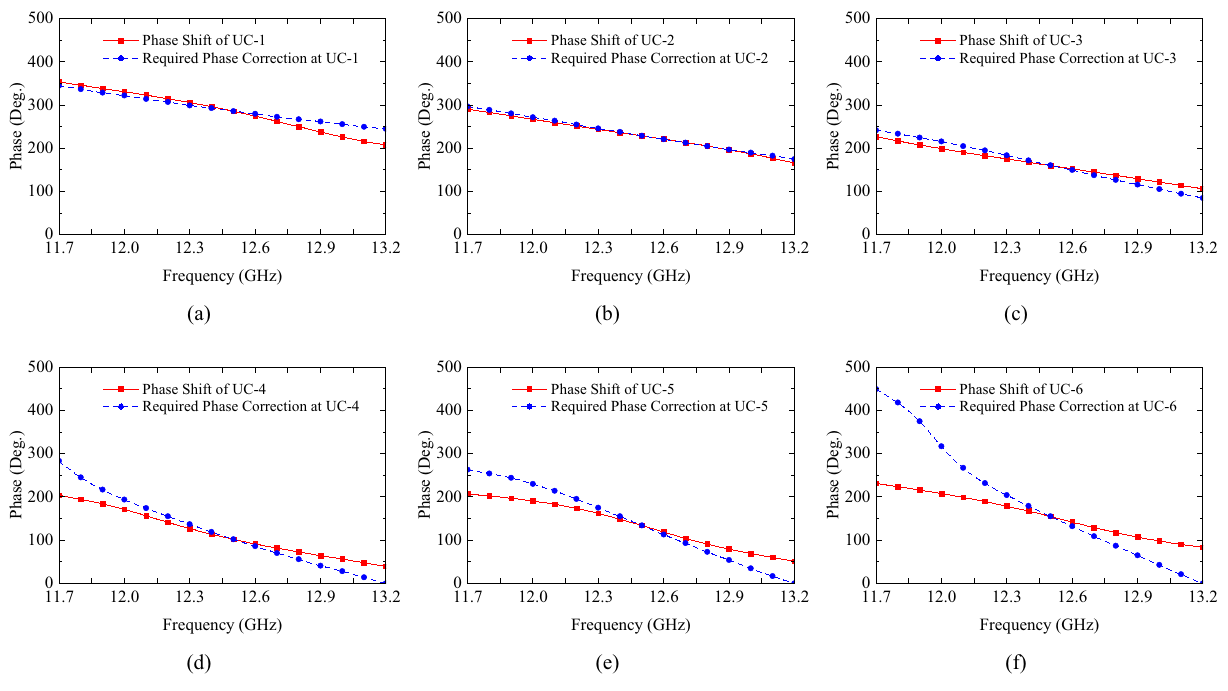
Figure 9. Phase shift of each DF-PSC and the phase correction required in the RCA aperture at each DF-PSC location versus frequency. (UC-1 is at the center of the antenna aperture and UC-6 is the